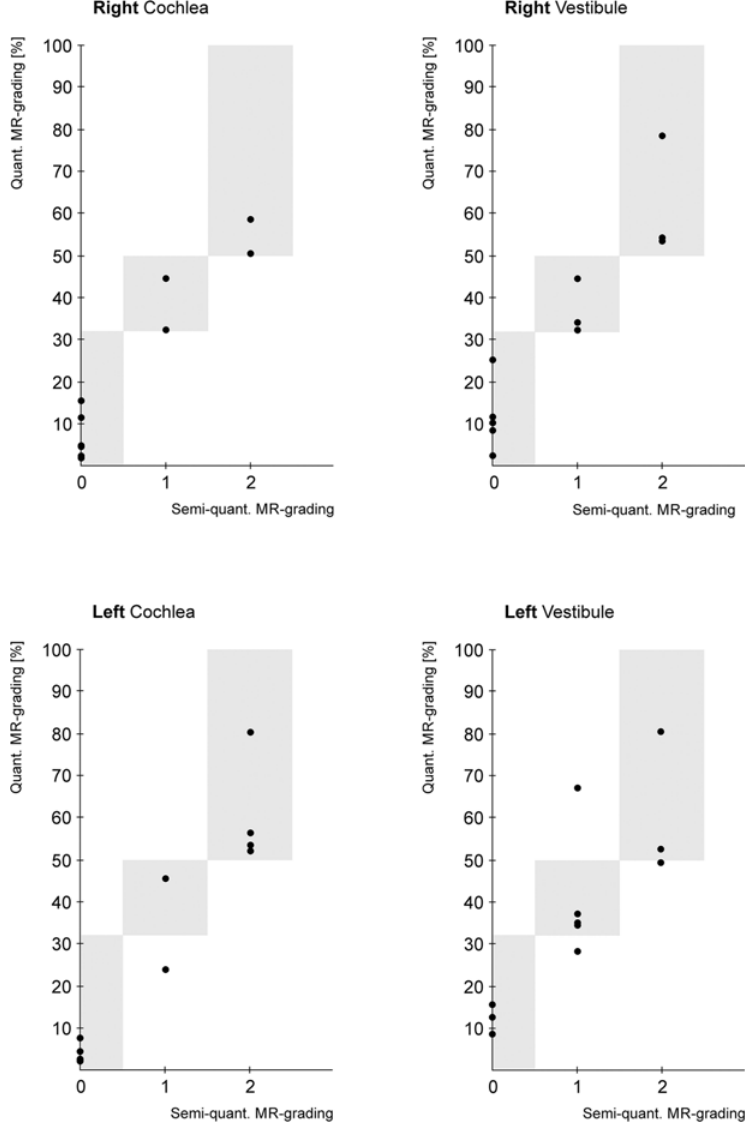
Fig 2. Comparison of volumetric [%] and semi-quantitative [0: No endolymphatic hydrops; 1: Mild endolymphatic hydrops; 2: Significant endolymphatic hydrops] evaluation of the degree of endolymphatic hydrops. The grey boxes reflect the grade margins of the volumetric approach (grade 0: < 33%; grade 1: 33 – 50%; grade 2: > 50%). The total correlation coefficient for vestibular and cochlear structures is 0.92. No significant difference was detected between volumetric and semi-quantitative approach (p >